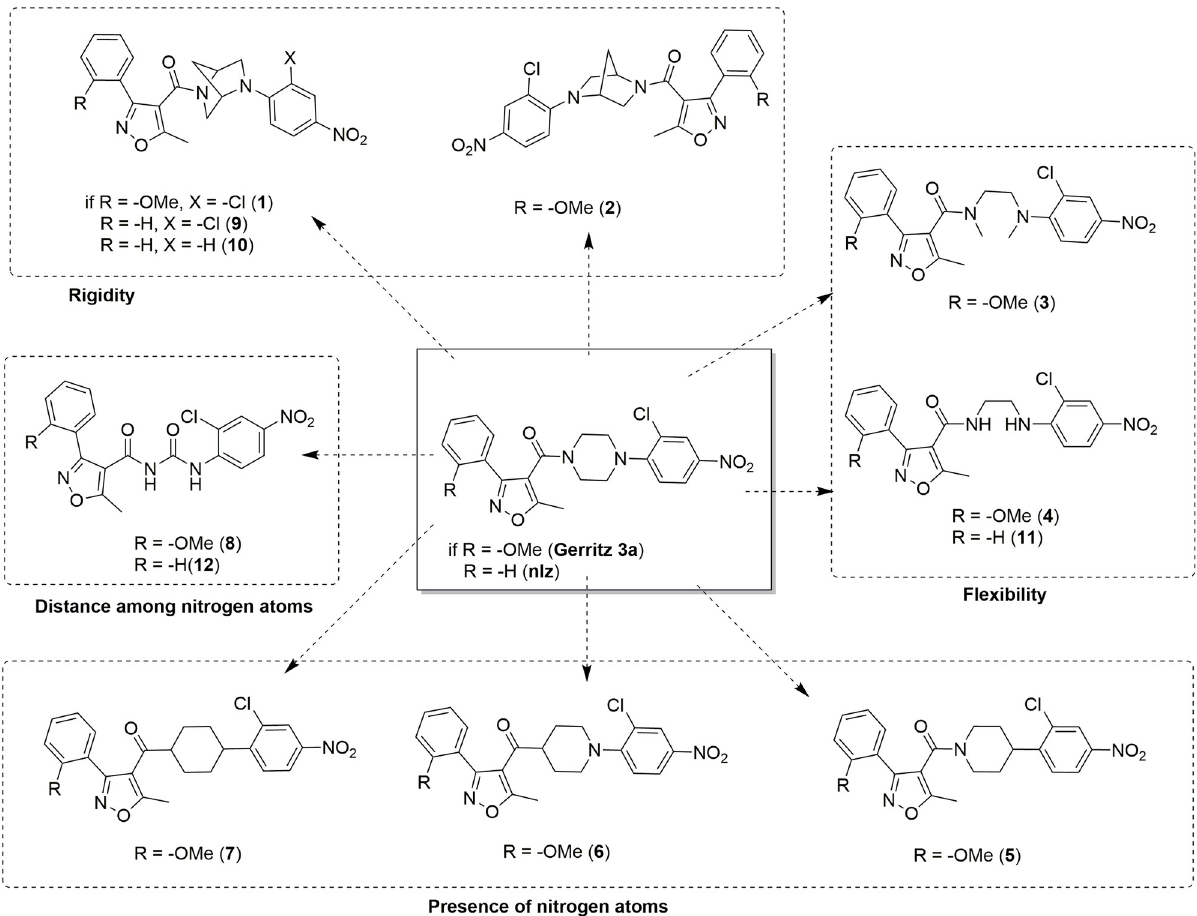
Fig 2. Analogs proposed in this work to study the influence of the piperazine moiety over the antiviral activity within the nucleozin derivatives.